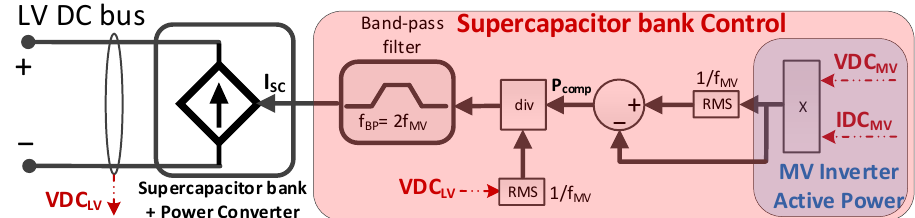
Figure 8. Computational model for the Supercapacitor